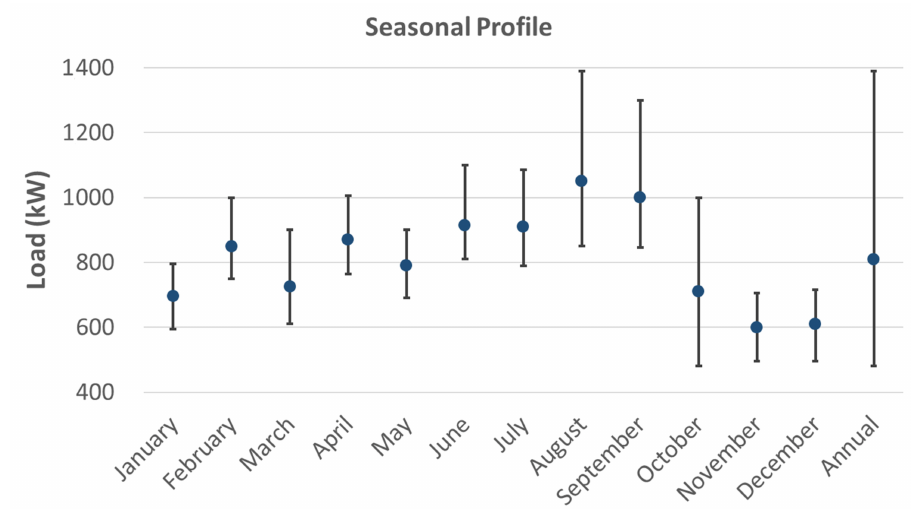
Figure 2. Monthly seasonal electricity load profile of Chiang Mai University (created by the authors).